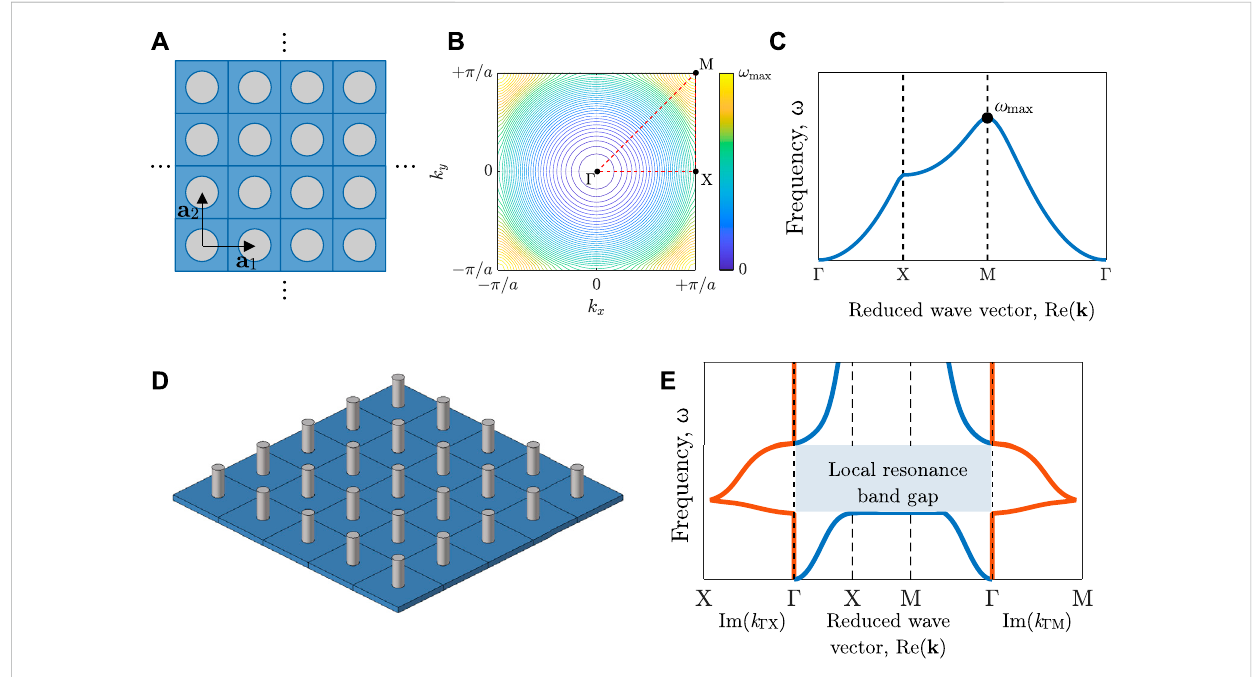
Two-dimensional periodic media and typical dispersion relations. (A) Example of aPC with direct lattice vectors a 1 and a 2 , with (B) its fi rst dispersion surfacespanningthe fi rstBrillouinzoneforasquarelattice,{ k x , k y } ∈ [ − π / a , π / a ],showingthehigh-symmetrypointsgivenby Γ (0,0),X( π / a ,0),andM( π / a , π / a ), and (C) the corresponding band diagram obtained using the contour of the irreducible Brillouin zone ( Γ XM Γ path). (D) Locally resonant structures (pillars)embeddedinasquarelatticewiththe (E) correspondingbanddiagramshowingpropagatingwaves(bluelines),evanescentwavesinspeci fi c direction (red lines), and a highlighted local resonance band